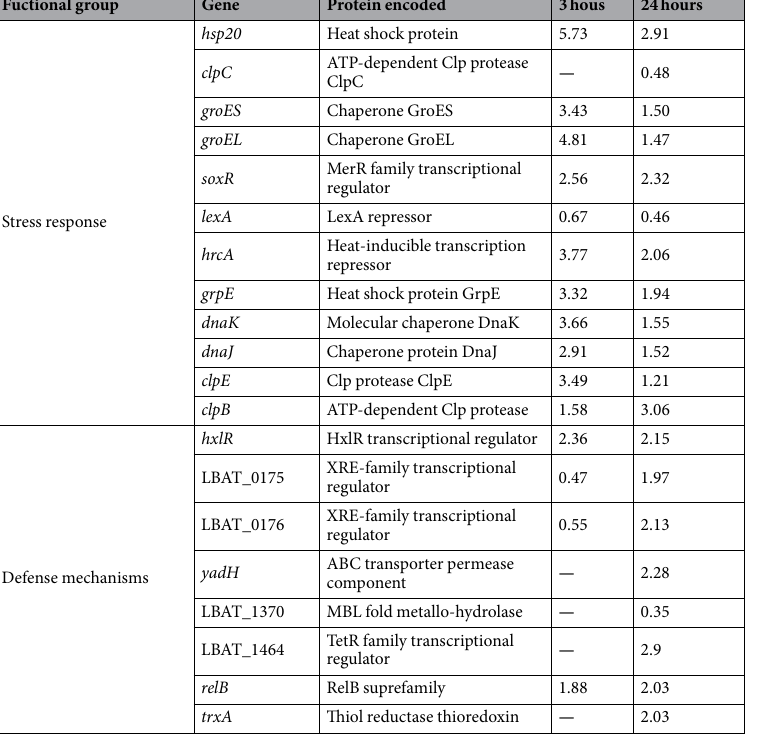
Table 1. The fold change value of genes, grouped into stress response and defense mechanism pathway after exposing to 12% (v/v) ethanol for 3 hours or 24 hours. —: no significant difference (q value >